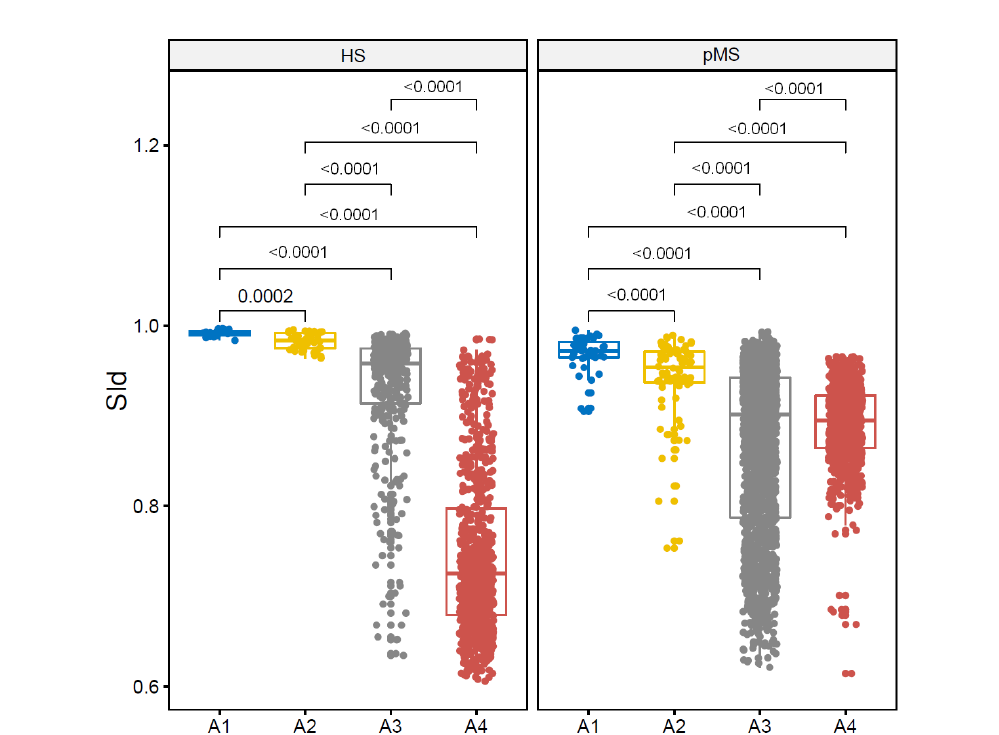
Figure 4. Comparison of SId predictions across configurations: Intra-individual intra-session prediction (A1) vs. intra-individual inter-session prediction (A2) vs. intra-group inter-individual prediction (A3) vs. inter-group inter-individual prediction (A4). Table 2. Similarity index scores for comparing one gait trial depending on the training trial (intra-individual inter-session, intra-group inter-individual, inter-group inter-individual). Means and standard deviations are displayed for both pMS and HS